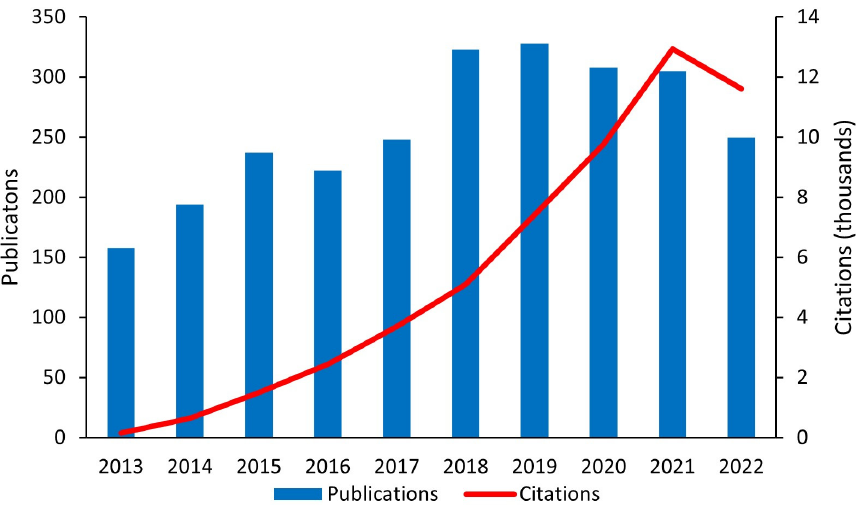
Figure 3. Research impact of thin-film polymeric nanocomposites analyzed using web of science database for the past decade.